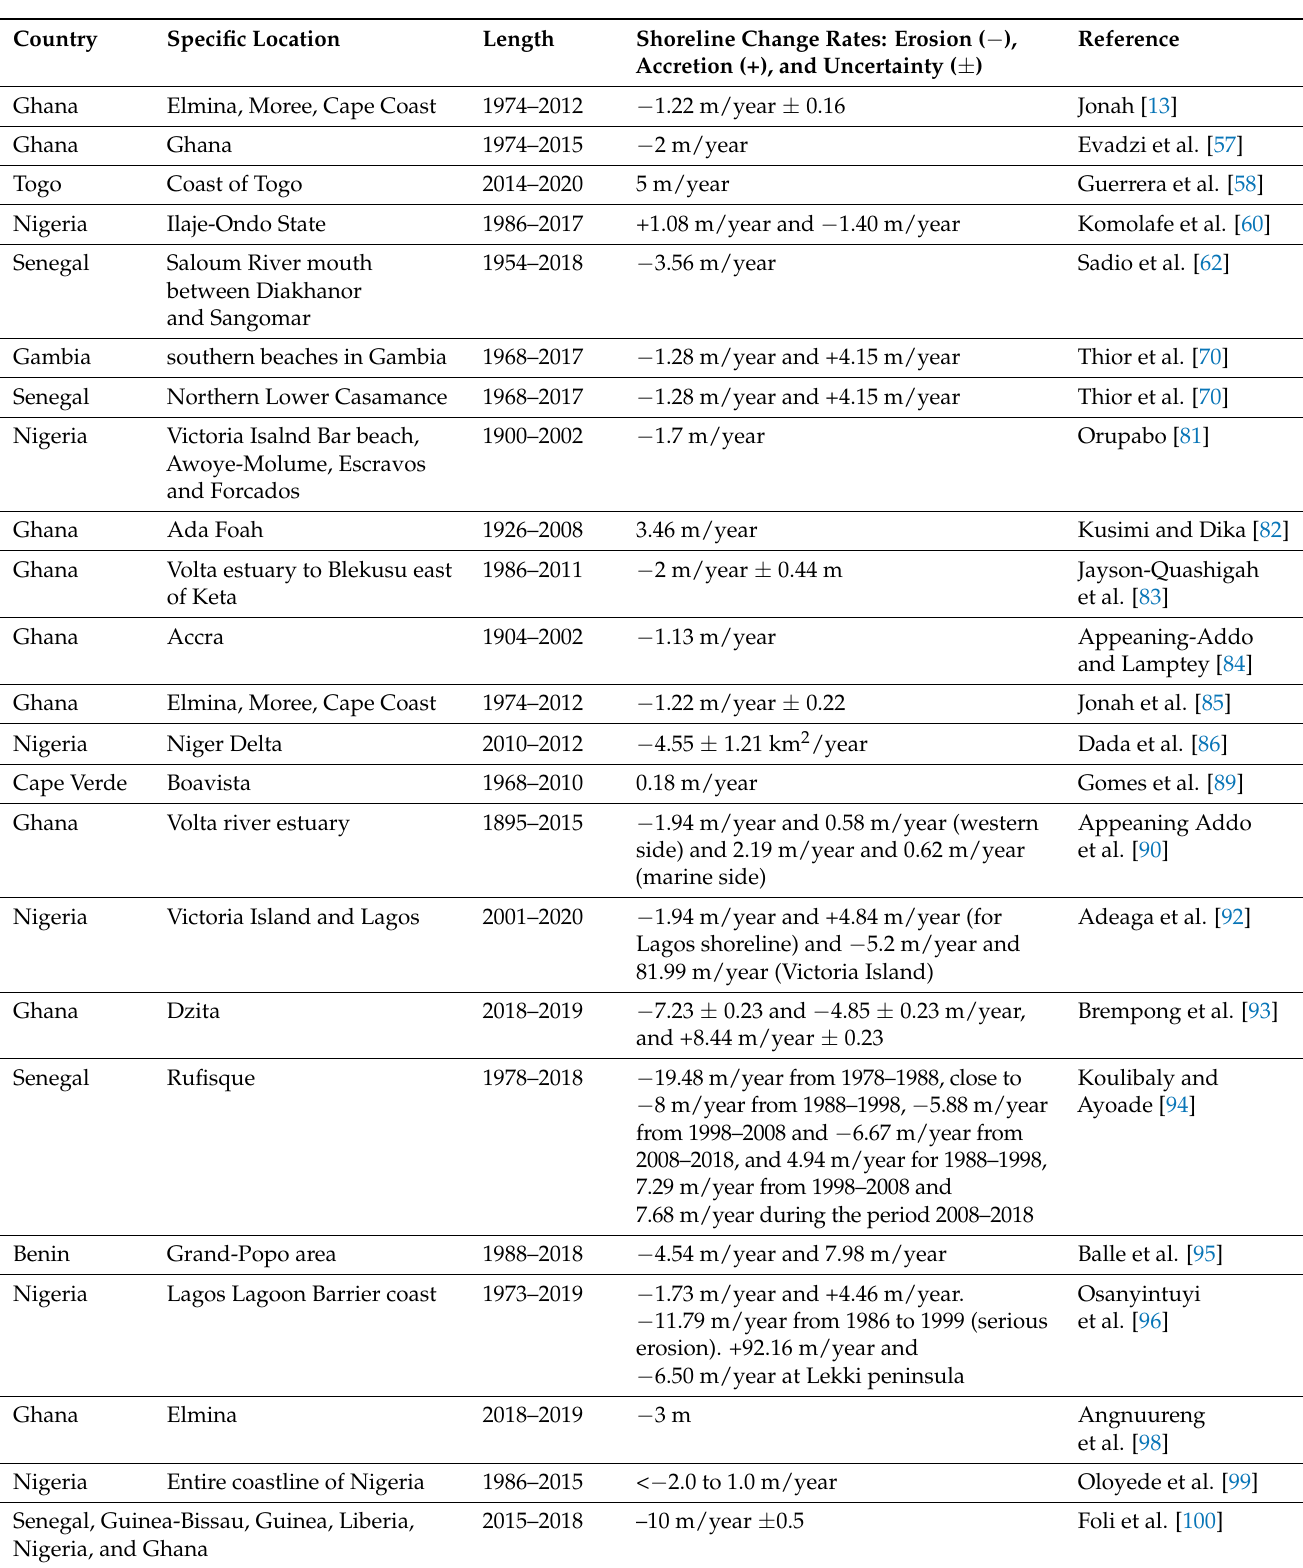
Table 1. Shoreline change rates along the West African